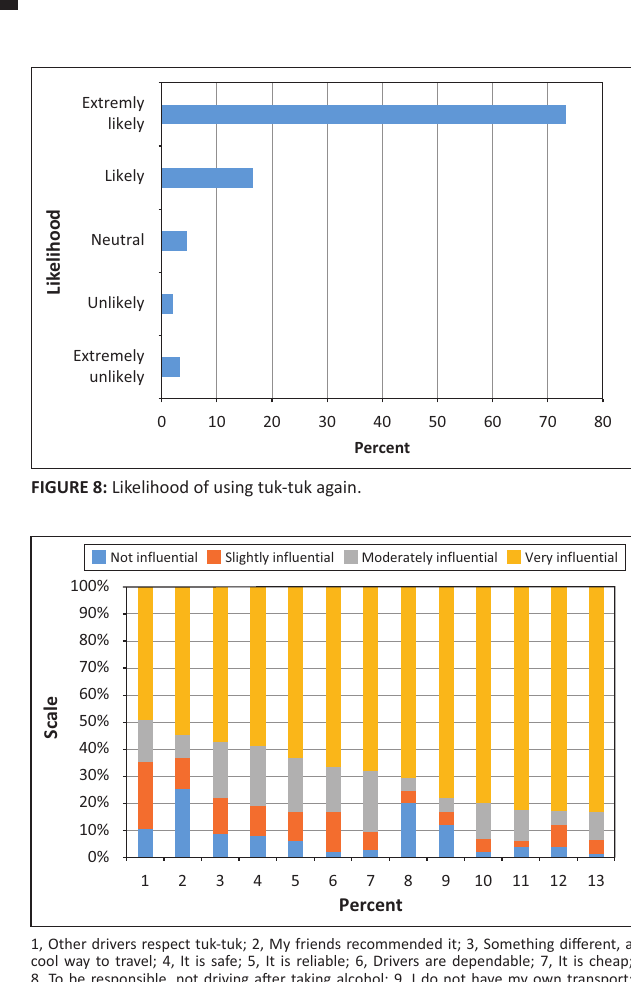
FIGURE 9: Factors influencing the choice of tuk-tuk as a means of